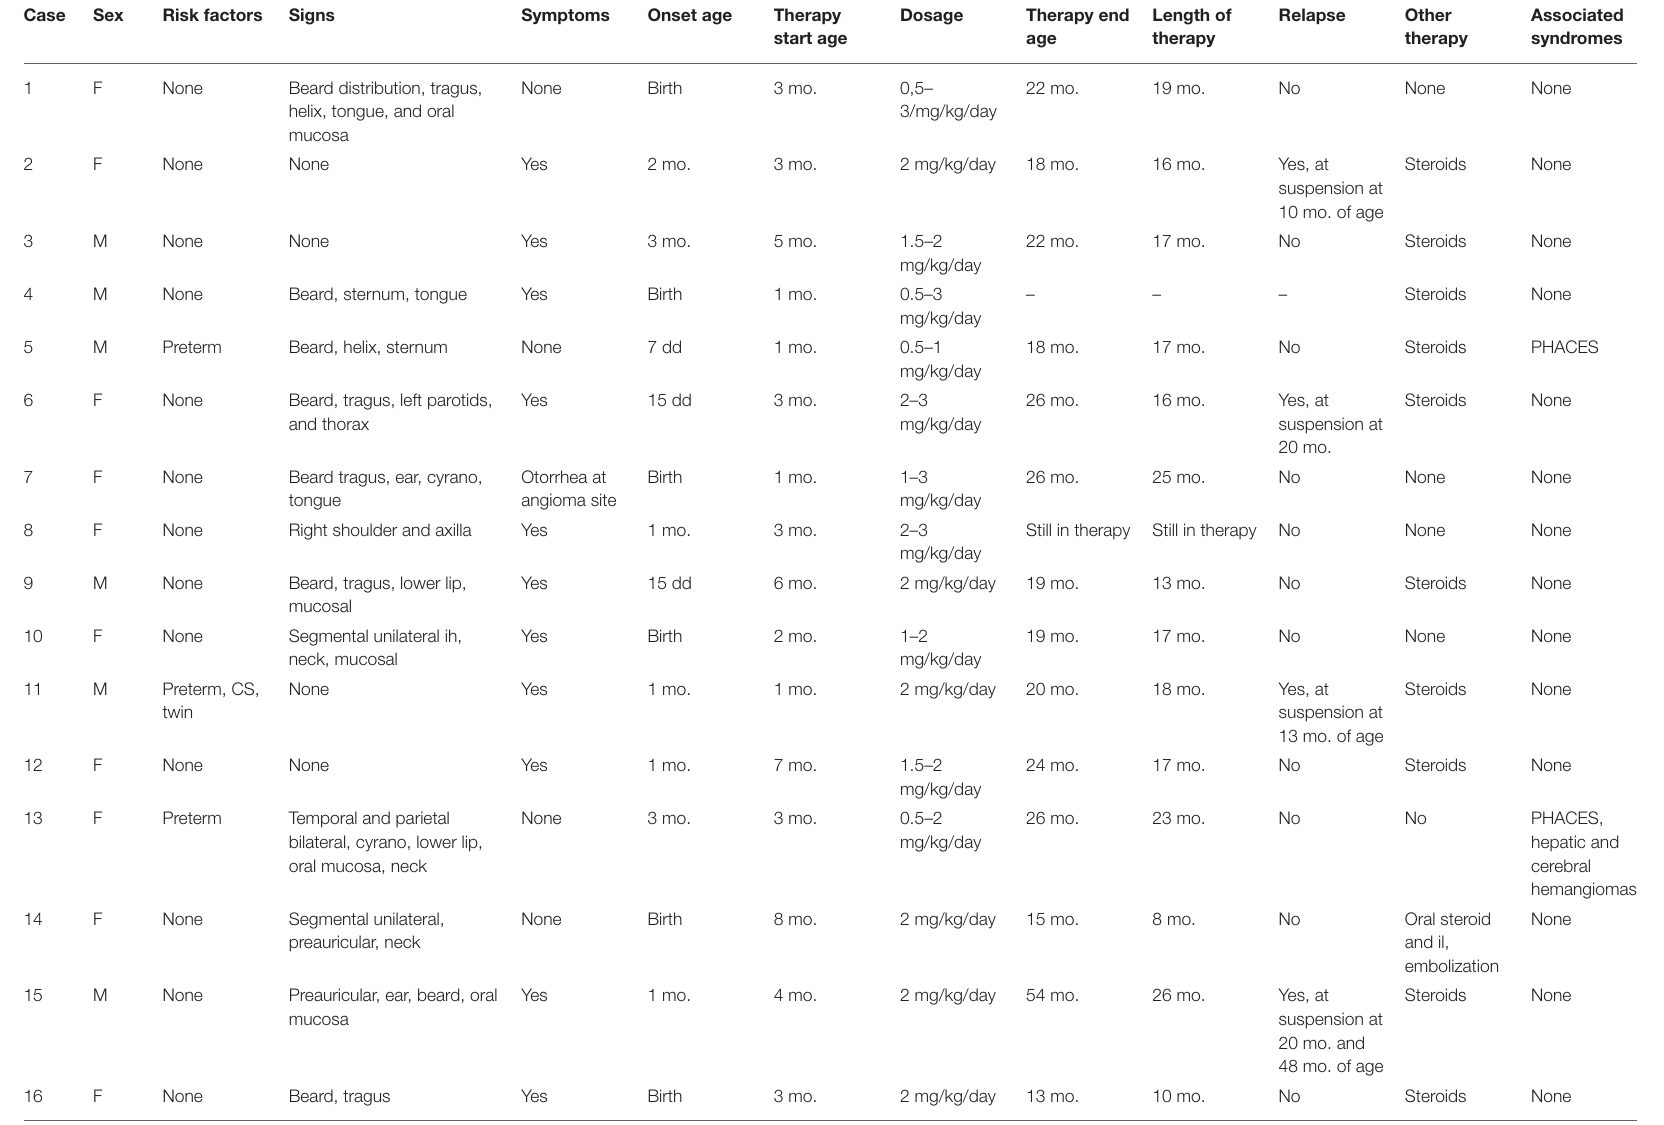
TABLE 1 | Demographics and clinical data from 36